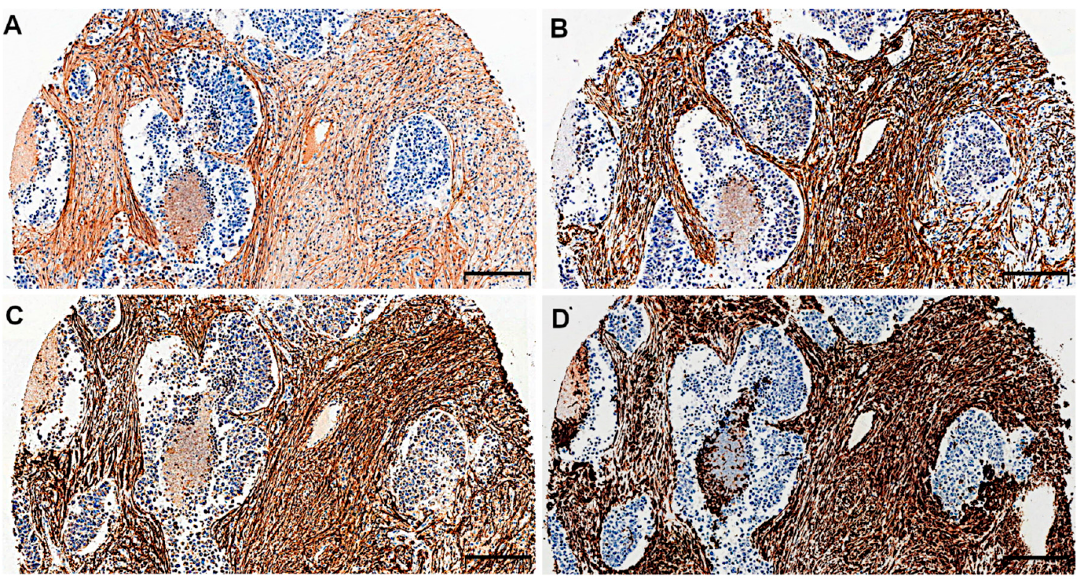
Figure 3. Serial sections of non-small cell lung carcinoma (NSCLC) immunostained for ( A ) periostin (POSTN), ( B ) α -smooth muscle actin ( α -SMA), ( C ) podoplanin (D2-40), and ( D ) vimentin in cancer-associated fibroblasts (CAFs). Magnification 50×. Bar = 200 µm.